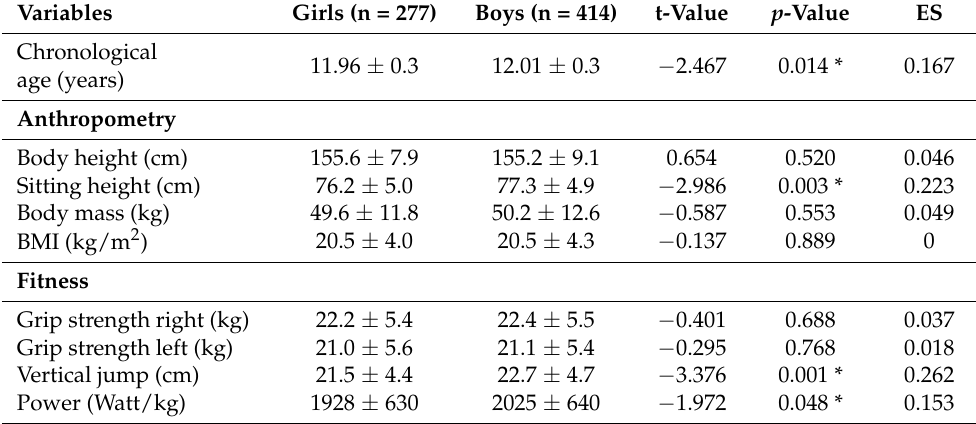
Table 2. Descriptive statistics of boys and girls and sex differences.